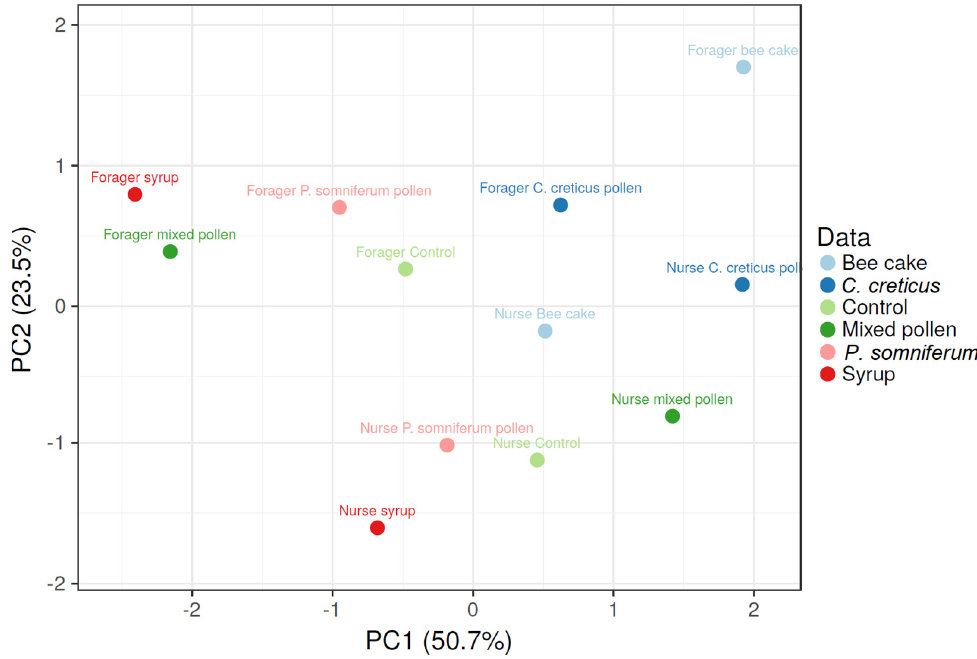
Figure 4. PCA was obtained according to HSP 70 values of forager and nurse bees before feeding and after in late fall and early spring. The first two components explained 74% of the data variance. The variables with loading values close to zero present a similar pattern in the forager or nurse bees.